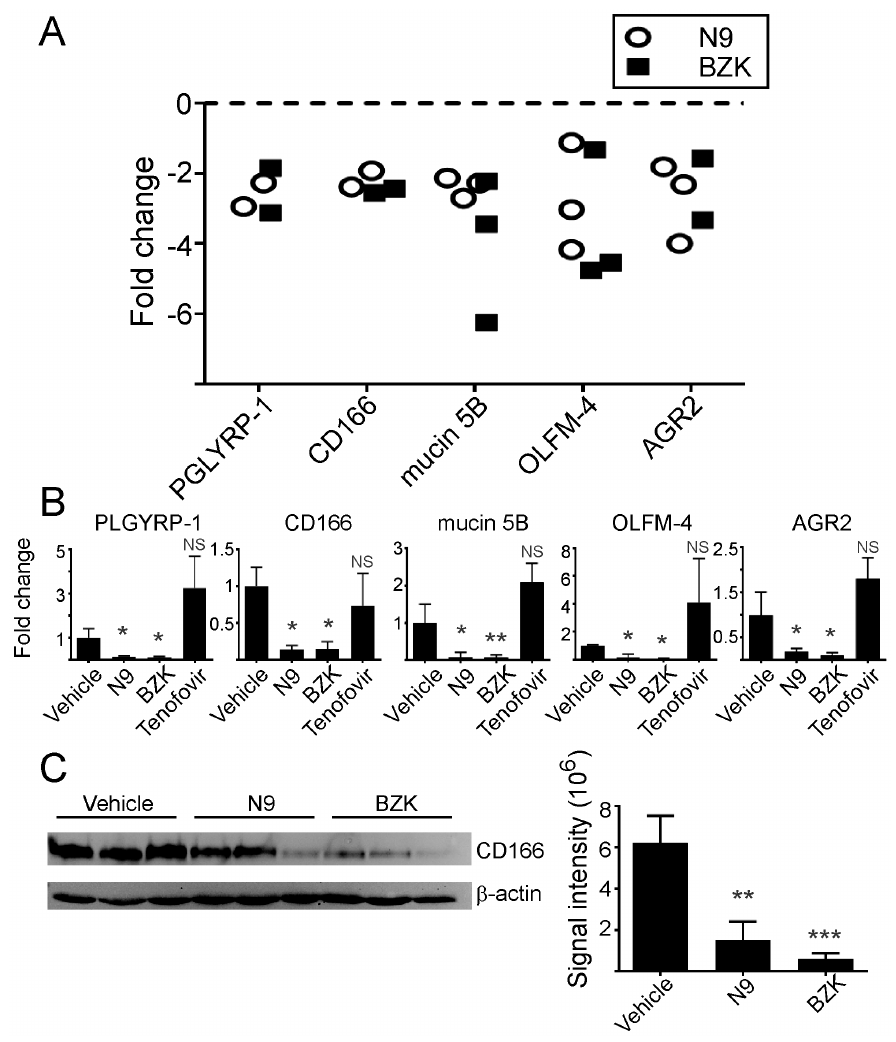
Figure 3. Quantitative proteomic and RT-PCR analysis of mouse tissue samples. (A) LC MS/MS proteomic analysis of mouse vaginal tissue samples down-regulated in response to treatment with N9 (open, black circles) or BZK (black squares). The following proteins are depicted in the graphs: peptidoglycan recognition protein 1 (PGLYRP-1), CD166 antigen (CD166), mucin 5 subtype B (mucin 5B), olfactomedin-4 (OLFM-4), and anterior gradient protein 2 homolog (AGR2). Each data point represents the average of three replicates per individual experimental study. Only proteins shown to change in a minimum of two studies are represented. (B) RT-PCR analysis of mouse mRNA expression. Relative expression levels are normalized to Glyceraldehyde 3-phosphate dehydrogenase (GADPH). Statistical analysis was performed using a two-tailed Student’s T-test of N9, BZK, and tenofovir samples compared to vehicle controls (***=p # 0.001, *=p # 0.05, NS=not significant). (C) Immunoblot of mouse CD166 antigen. Three mice per condition were analyzed. The CD166 signal was normalized to the b -actin signal for quantitation. Statistical analysis was performed using a two-tailed student’s T-test of N9 and BZK samples compared to vehicle controls (***=p # 0.001, **=p # 0.01). homolog (AGR2) (range 2 to 4-fold for N9 and 1 to 15-fold for